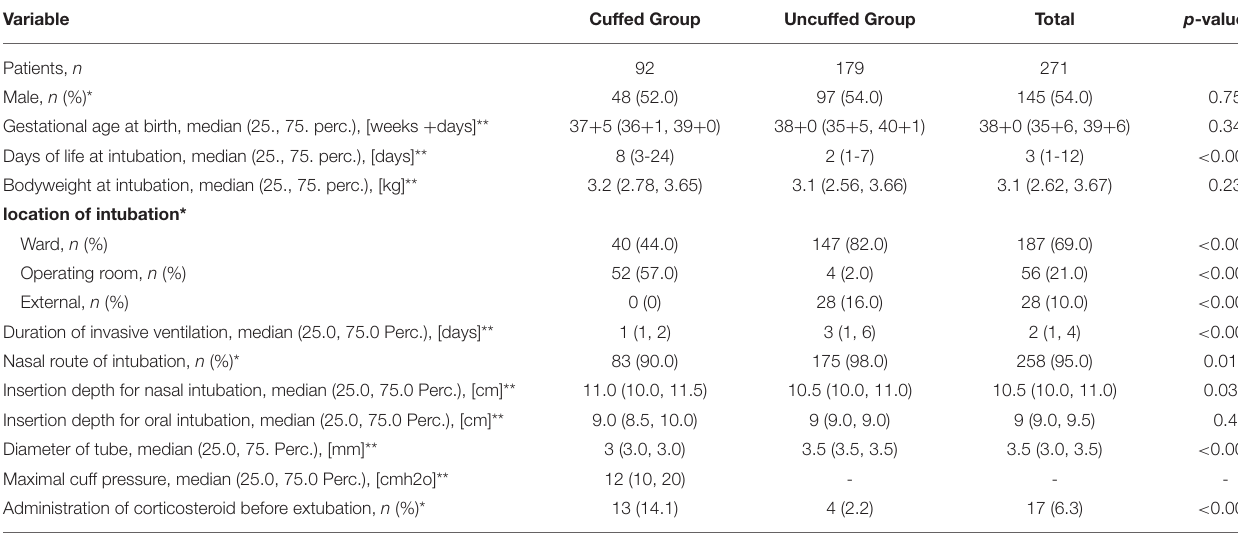
TABLE 1 | Baseline patient and intubation characteristics. Variable Cuffed Group Uncuffed Group Patients, n